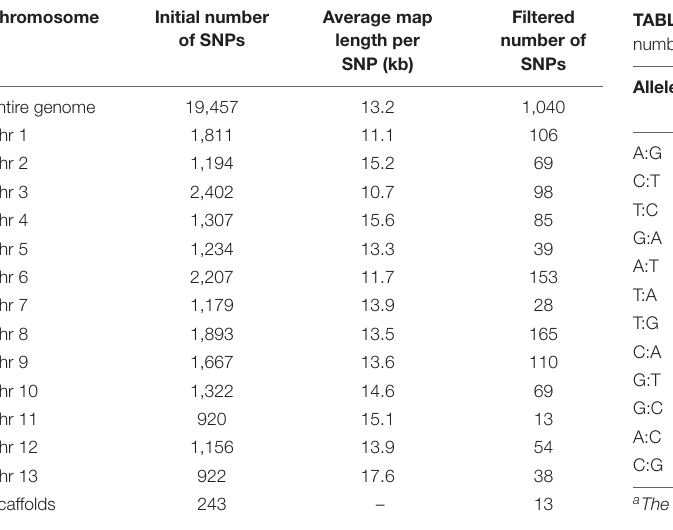
Candidate Gene Prediction Capsule shattering is predicted to be controlled by a single gene, and this phenotype was scored as a qualitative trait in the mapping analysis. Based on the Zhongzhi13, v2.0, sesame reference genome, it was mapped to coincide with SNP marker S8_5062843 (78.9 cM) near the end of LG8 (chromosome 8) ( Figure 3 ). The locus containing the SNP marker was visualized for capsule shattering and non-shattering parents and selected F 2 lines ( Figure 4 ). On chromosome 8, the nucleotide “A” was found in the reference genome at this SNP position, while the “T” nucleotide was observed in the non-shattering parent line (KP). Accordingly, the parental line (NP) with the shattered capsule trait had a sequence identical to the reference genome